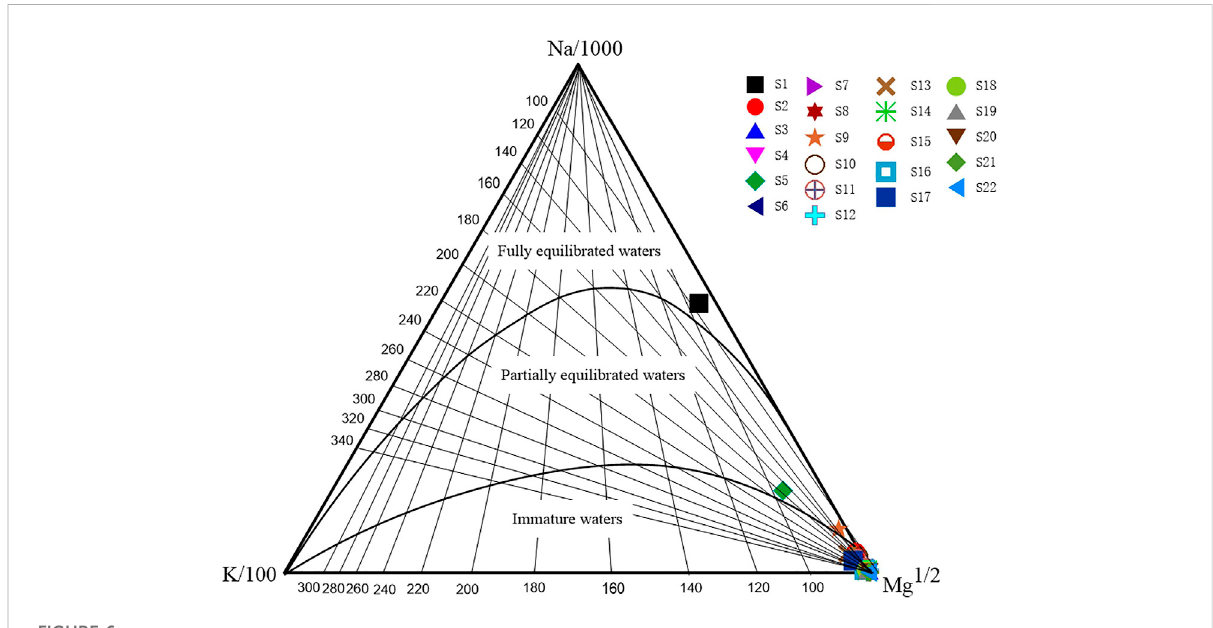
FIGURE 6 Na – K – Mg ternary diagram of the thermal spring water